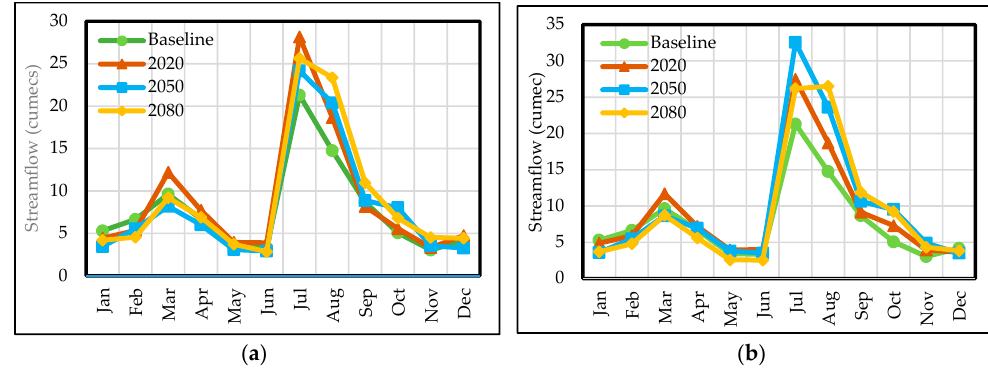
Figure 8. Monthly variation in streamflows of Haro River under ( a ) RCP 4.5; ( b ) RCP 8.5.